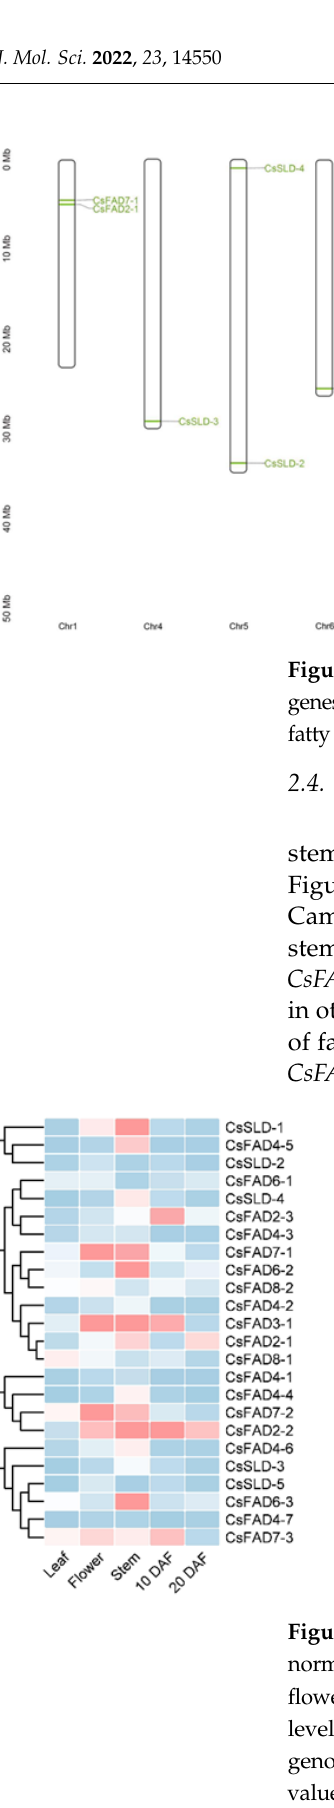
represent 50 amino acids. Yellow represents CD sequences, black lines represent introns, and blue represents non-coding regions (UTR). Scale bars represent 500 bp.